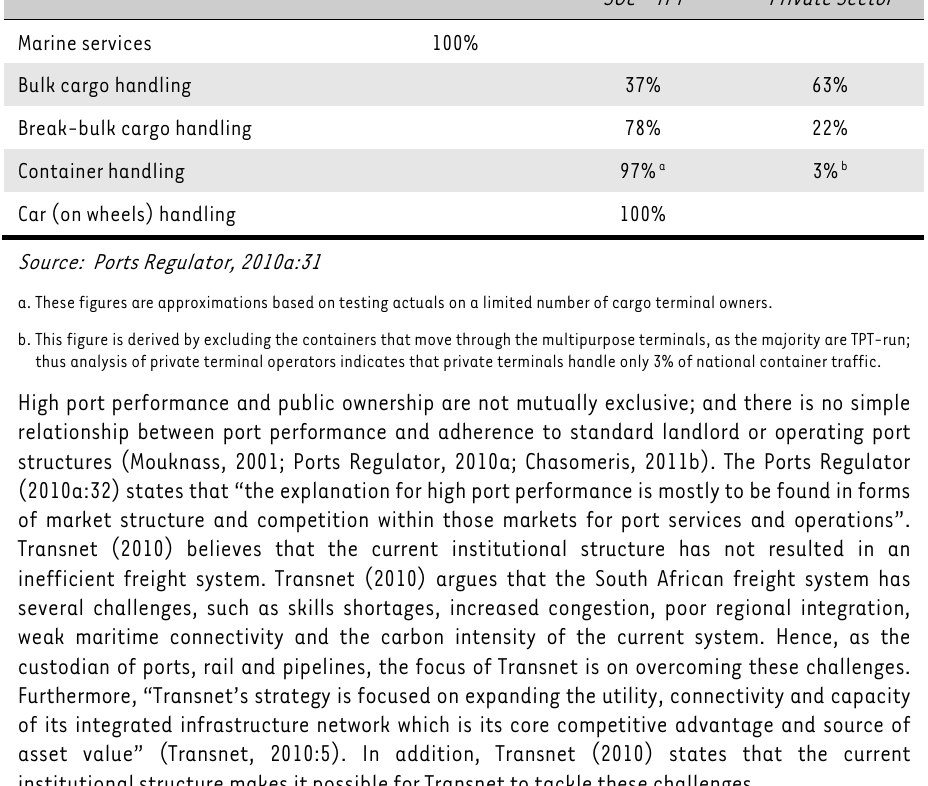
TABLE 2: Public and Private Sector Market Share for Major Service Categories Service